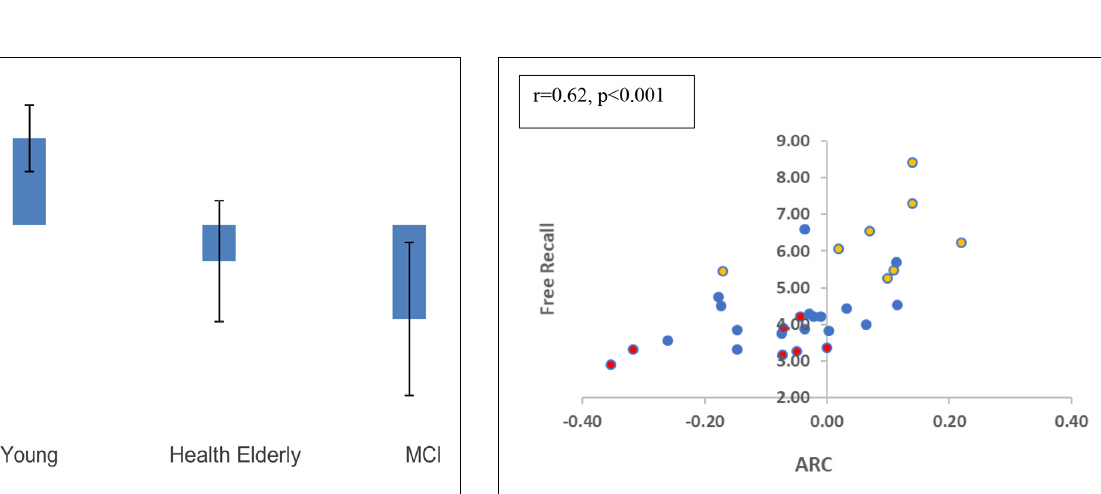
FIGURE 4 | Free recall in related trials and ARC correlation (blocks 2 + 3 collapsed). Colors refer to the different groups (Yellow-Young subjects/Blue-Healthy